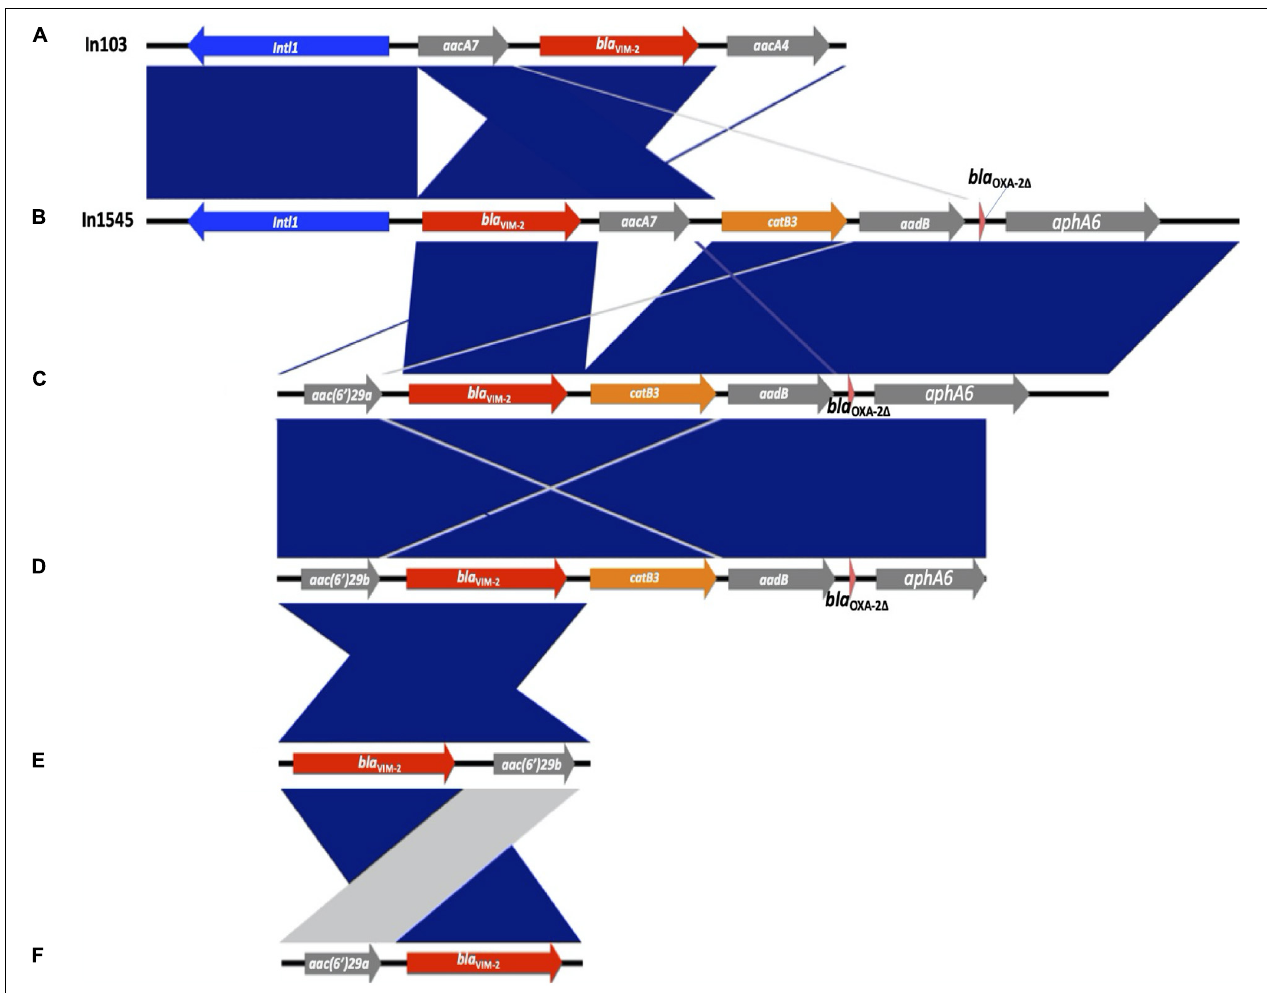
FIGURE 2 | Genetic comparison of the bla VIM − 2 -containing class 1 integrons detected in this study and gene cassette arrays. The different types of gene cassette arrays identified are designated from (A) to (F) . Genes are denoted by horizontal arrows with their corresponding transcription orientations. bla VIM − 2 is shown with red arrows. Figure was created using